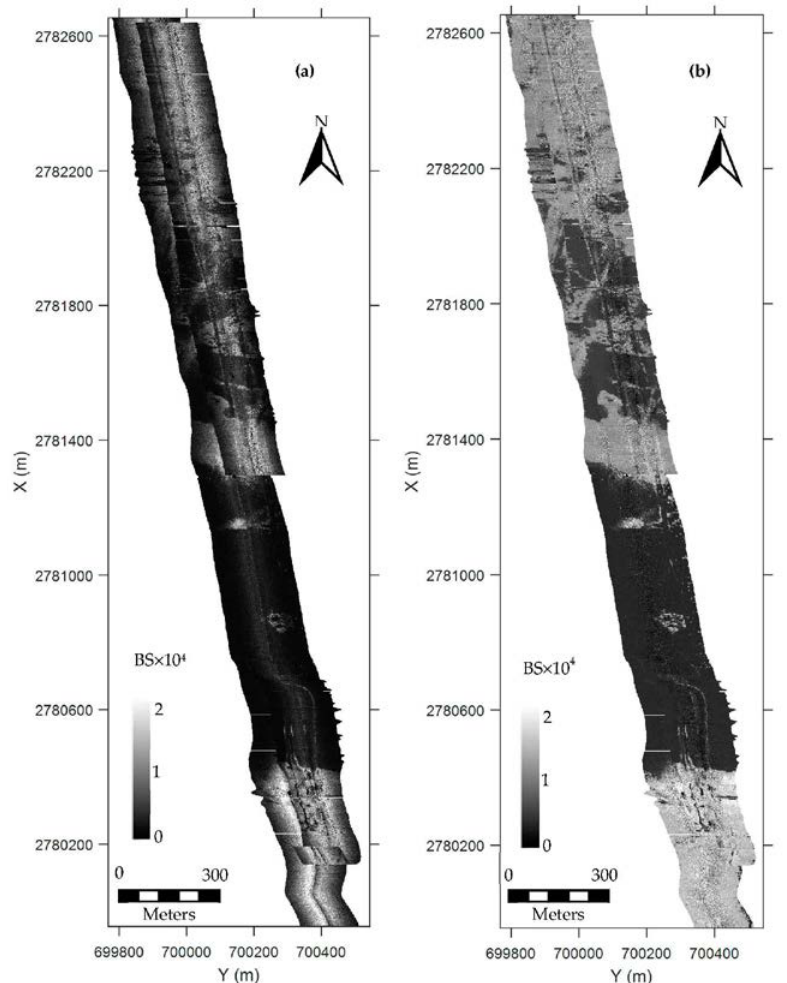
Figure 14. Comparison of raw and corrected sonar images of the entire seabed: ( a ) raw sonar image; and ( b ) image corrected with the proposed method. X and Y are the location coordinates projected using universal transverse Mercator projection in Zone 50.